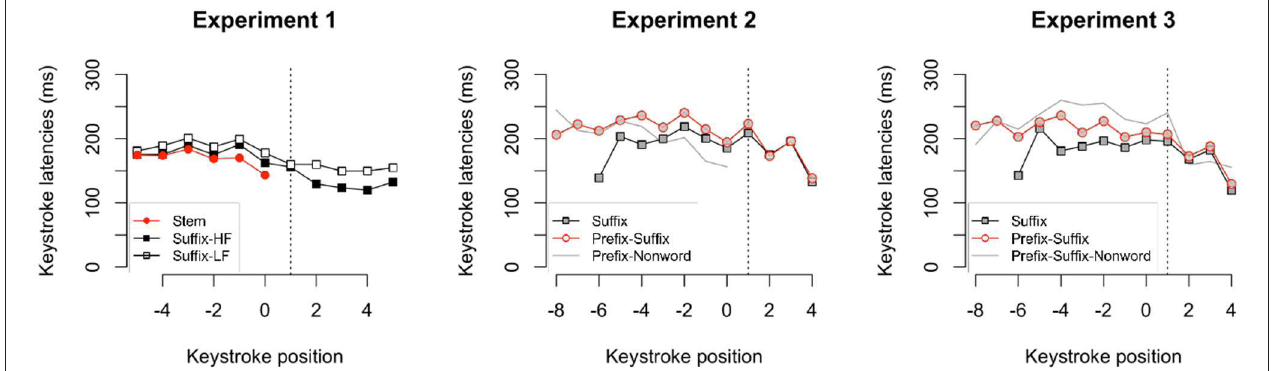
FIGURE B1 | Mean keystroke trajectories (excluding the first keystroke) aligned to the offset of the stem for all conditions in Experiments 1, 2, and 3. The onset of the suffix is indicated with a dashed vertical line.